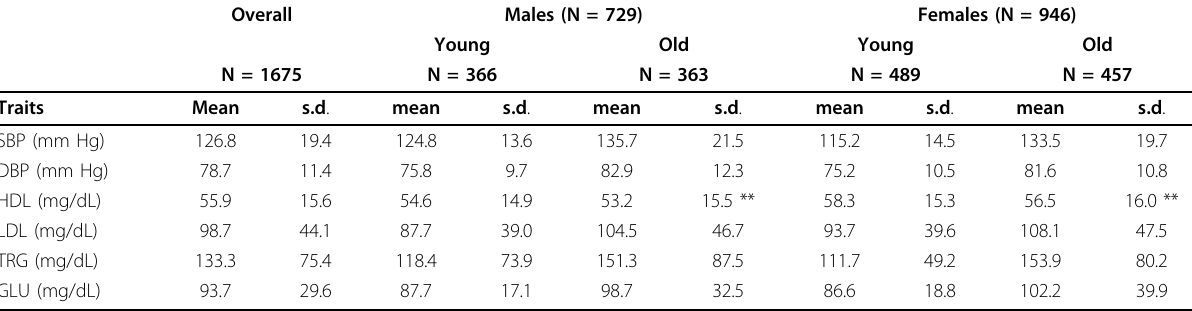
Table 2 Summary statistics for the entire sample and stratified by sex and age